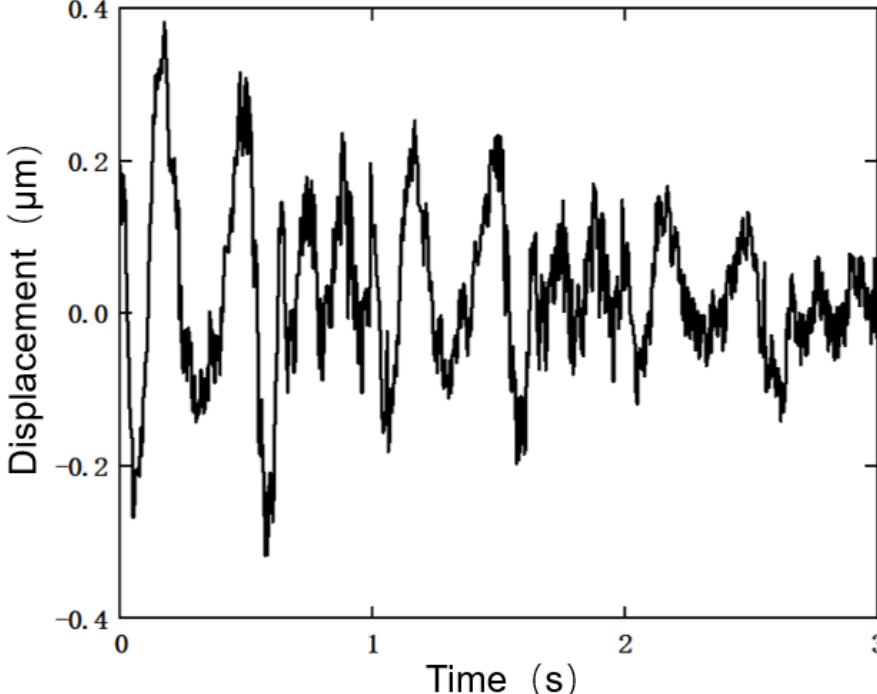
Figure 25. Displacement error diagram of y direction variable-amplitude signal.